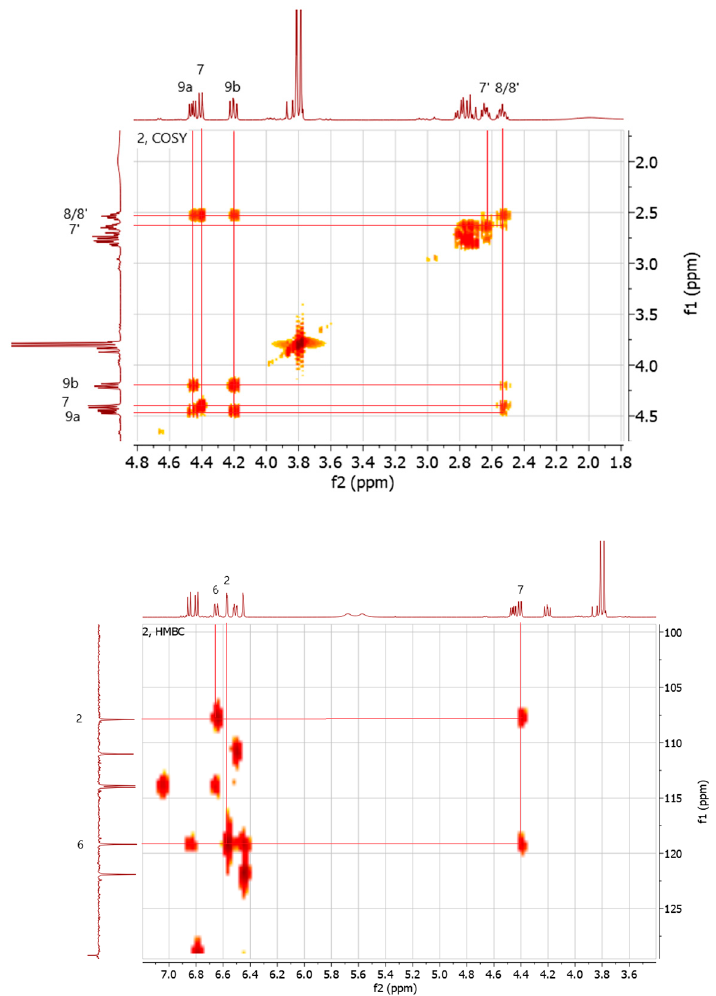
Figure 2. Most relevant COSY and HMBC interactions for 7 R -HMR structure